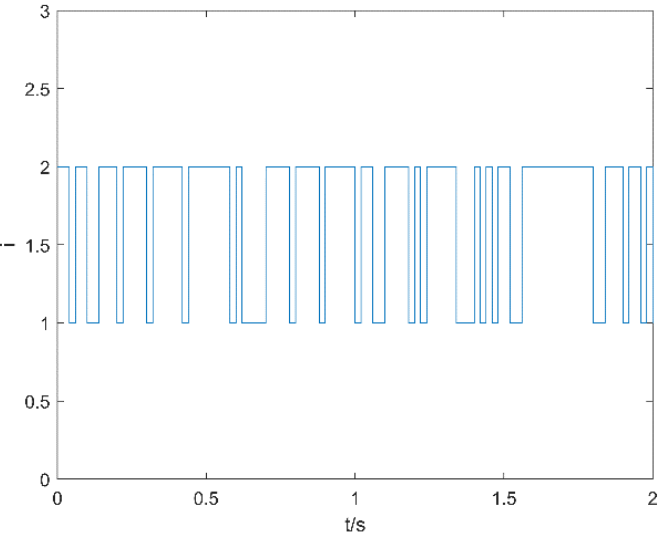
Figure 1. One possible Markovian mode evolution.